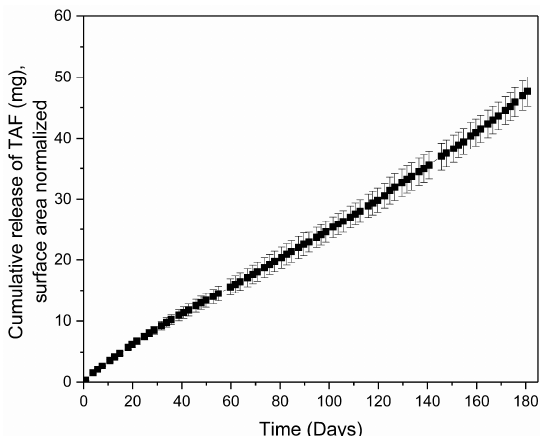
Figure 6. Cumulative release of TAF (mg) from an implant comprising Sigma-PCL of 100 µm wall thickness at 2.5 mm outer diameter and 40 mm length. Implants contained a 2:1 TAF-castor oil formulation. Three implants were tested per condition.